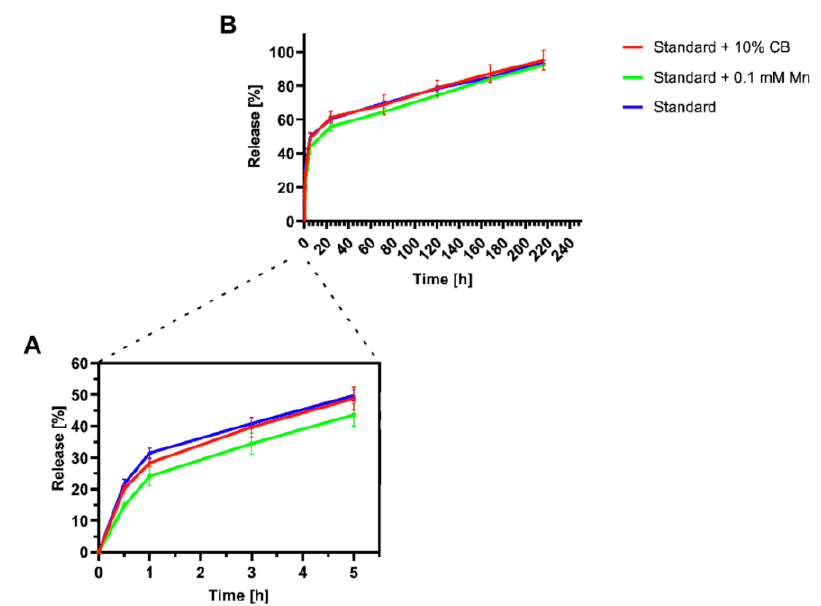
Figure 4. Permeability analysis of alginate hydrogels: ( A ) The release profile of dextran 70 kDa conjugated with FITC from SD hydrogel with compact manganese alginate particles/Mn 2+ /without manganese addition during the first 5 h; and ( B ) The release profile of dextran 70 kDa conjugated with FITC released from SD, SD + 10% CB or SD + 0.1 mM Mn 2+ hydrogels for the following days. Data presented as mean ( ± SD), n =